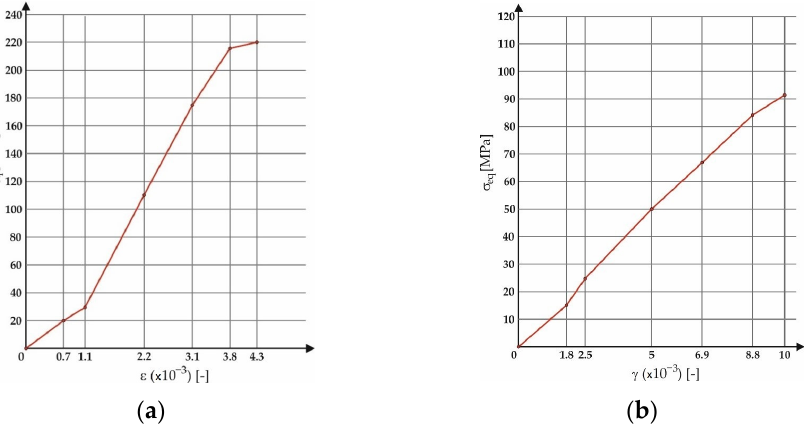
Figure 14. Multiaxial fatigue test system: 1—a specimen, 2—jaws for clamping a specimen, 3—a table (a support) of the test system, 4—a PC controlling and processing system, 5—acting components of the test system (under the table).